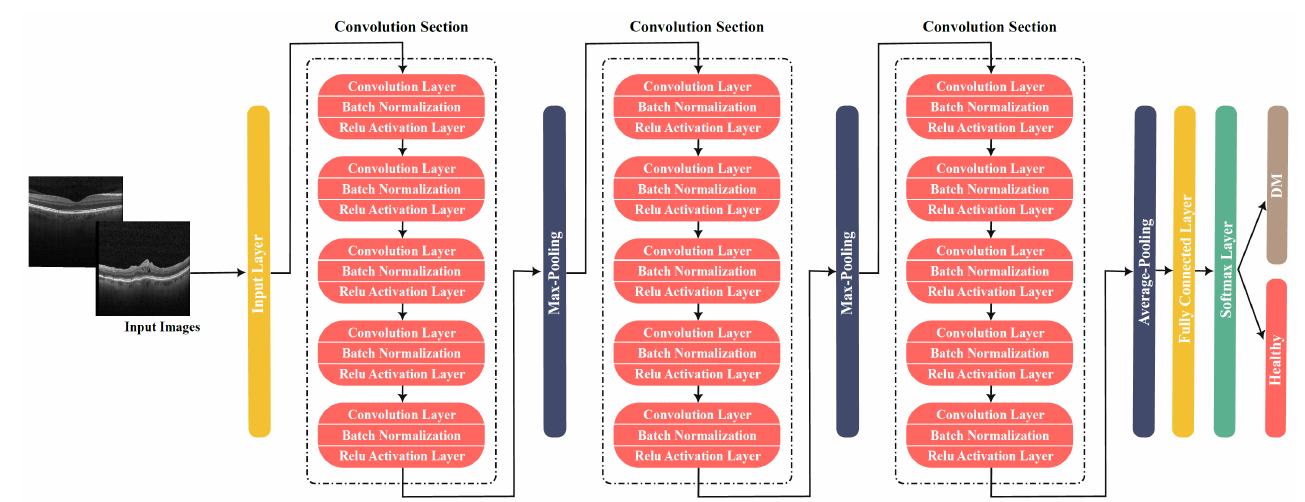
Figure 10. Optimal design of the DLN in Experiment 2. The estimated objective function values plot over the optimization iterations is de- picted in Figure 11. The optimum model recorded a test error of 0.0418, test accuracy of 95.8%, and a generalization error rate of [0.0335, 0.0502] at a 95% confidence